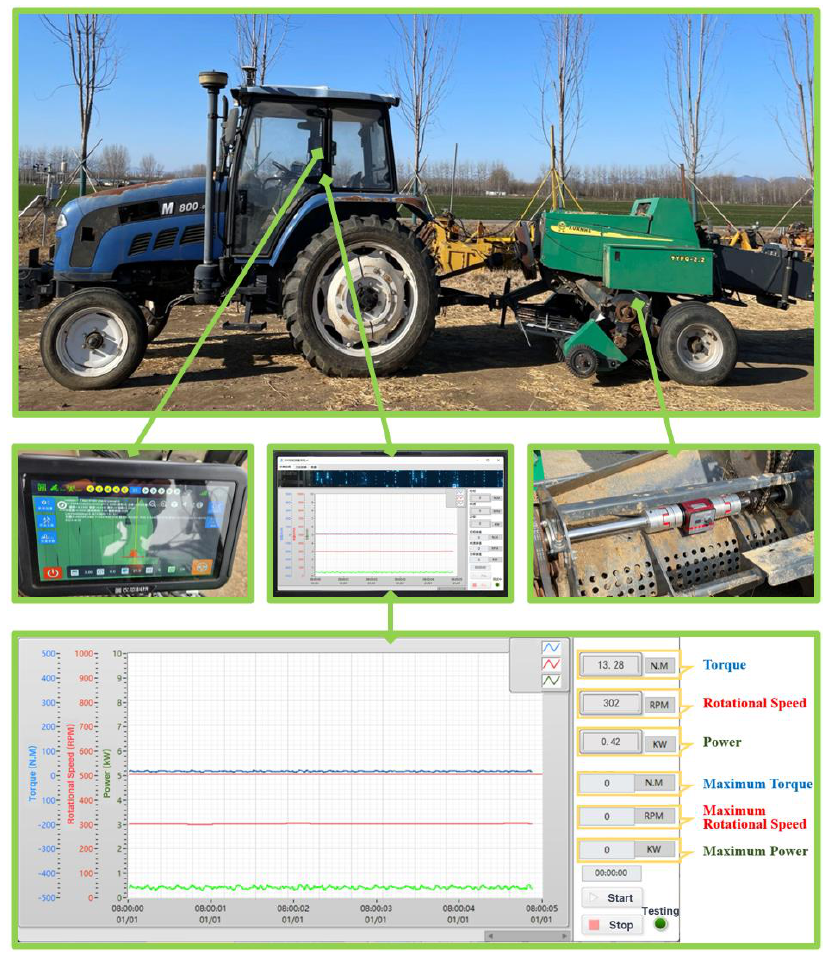
Figure 4. Test equipment.